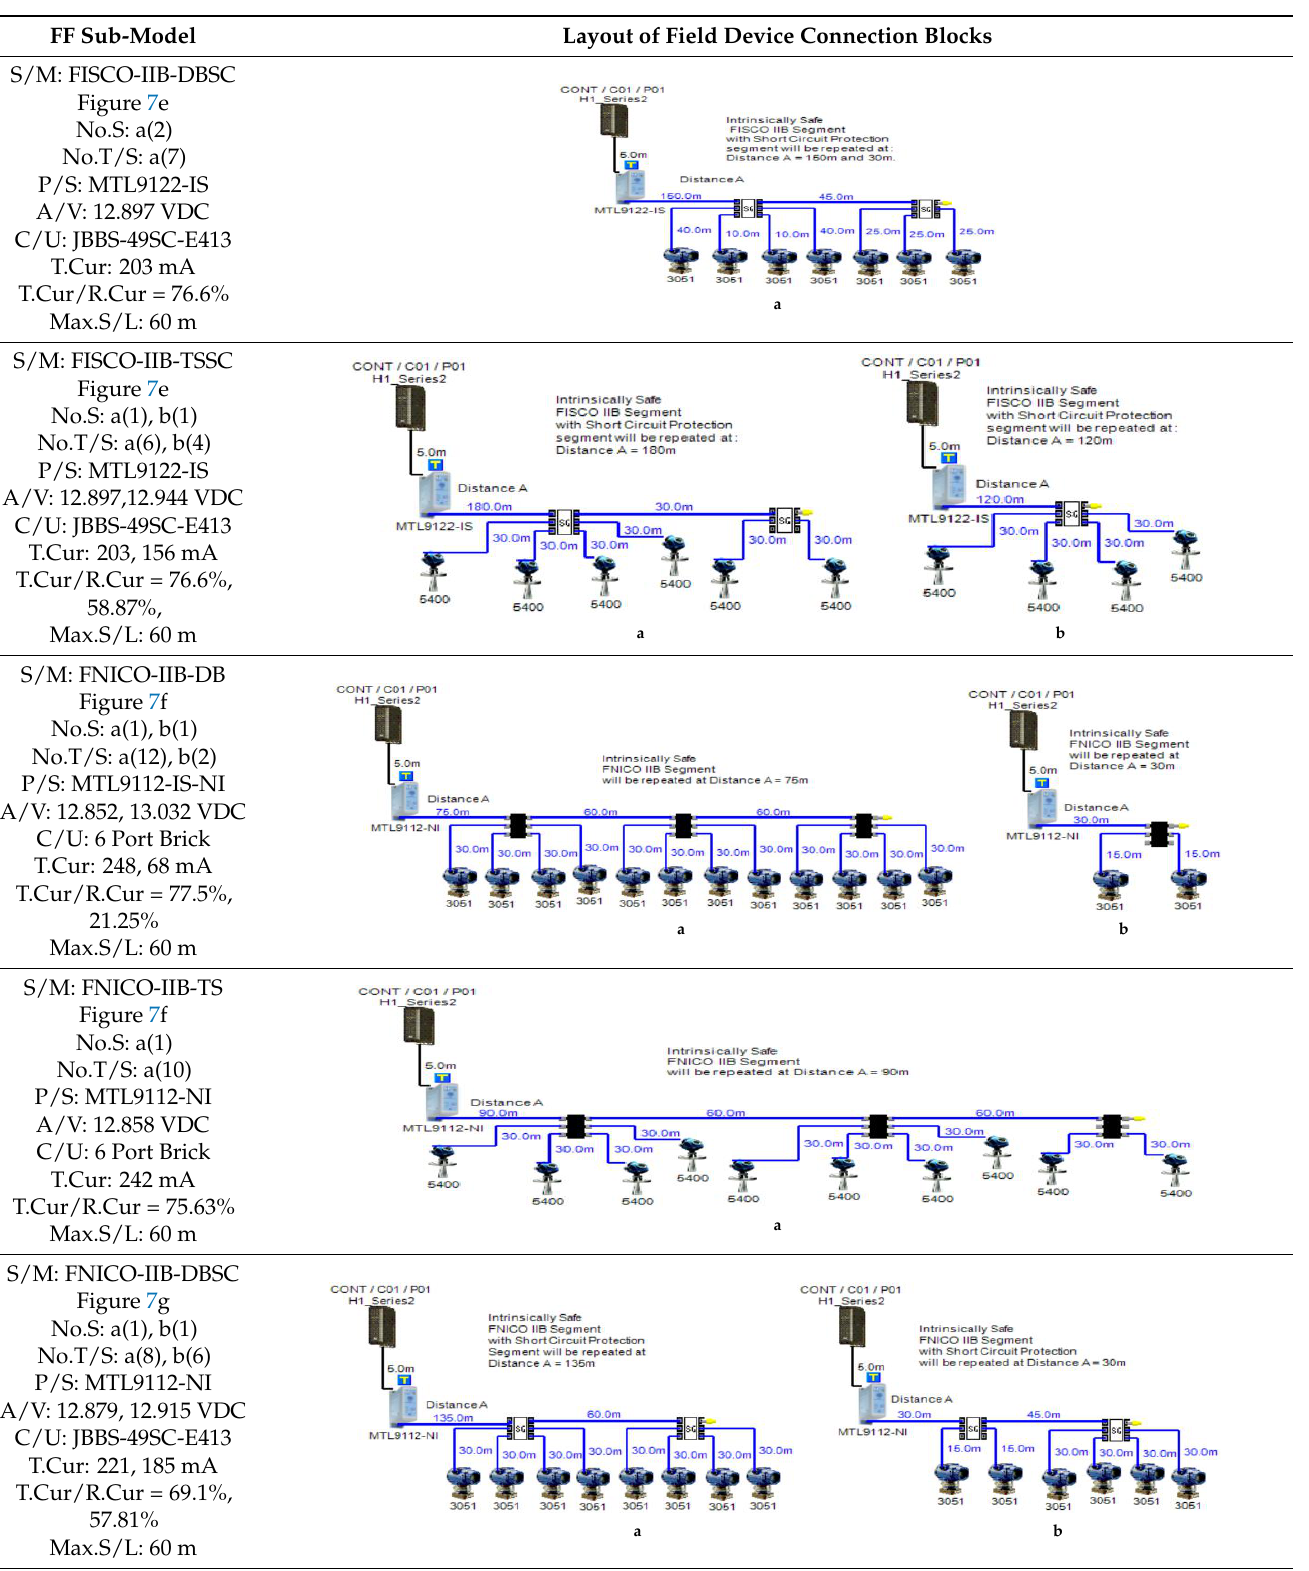
15 of 36 S/M: FISCO-IIB-DB Figure 7c No.S: a(2) No.T/S: a(7) P/S: MTL9122-IS A/V: 12.942 VDC C/U: 6 Port Brick T.Cur: 138 mA T.Cur/R.Cur = 53.9% Max.S/L: 60 m a S/M: FISCO-IIB-TS Figure 7c No.S: a(1), b(1) No.T/S: a(8), b(2) P/S: MTL9122-IS A/V: 12.942 VDC C/U: 6 Port Brick T.Cur: 200, 54 mA T.Cur/R.Cur = 75.47%, 20.38% Max.S/L: 60 m a b S/M: FISCO-IIC-DB Figure 7d No.S: a(3), b(1) No.T/S: a(4), b(2) P/S: MTL9121-IS A/V: 12.316 VDC C/U: 6 Port Brick T.Cur: 84, 68 mA T.Cur/R.Cur = 70%,